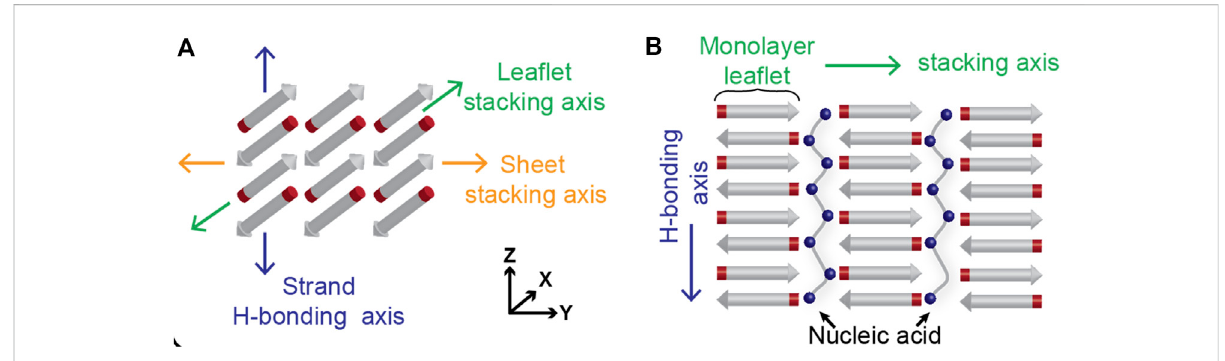
FIGURE 1 Cross- β architecture allows for packing of other polymers in between the lea fl ets. Hydrogen bonding across amides from consecutive peptide strands contribute to lea fl et formation in the z -axis, while side chain interactions contribute to the stacking of β -Sheets along the y -axis (A) . The lea fl ets, where the peptide termini are positioned, have been shown to accommodate polyanionic species like polyphosphates and oligonucleotides (B)